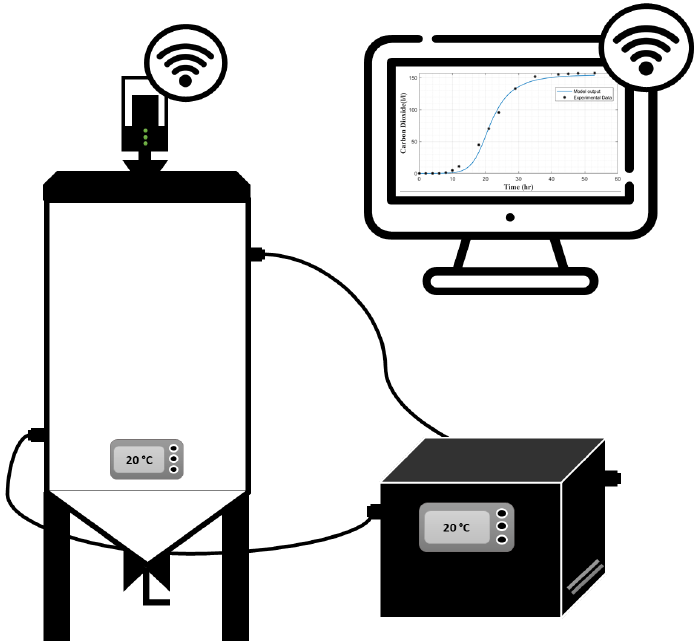
Figure 1. Stainless-steel fermenter pilot plant monitoring set-up.